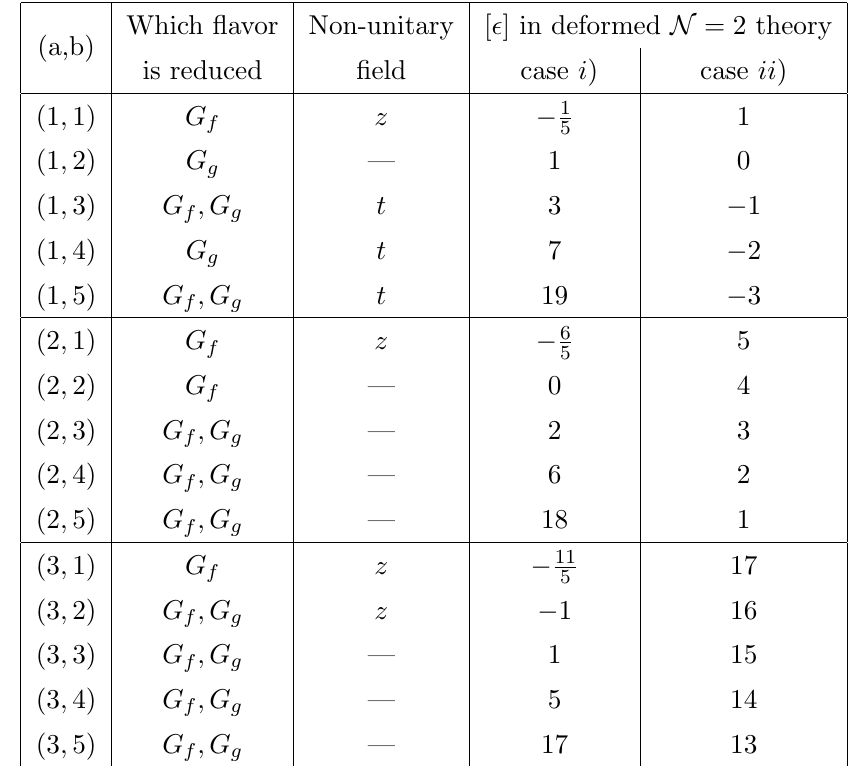
Table 2. Overview table of SCFT scaling dimensions. For (cid:12)xed ( a; b ) the (cid:13)avor symmetry reduction is listed, as is the non-unitary (cid:12)eld of method one, and the scaling dimension of the deformation parameter (cid:15) of the = 2 theories using method N